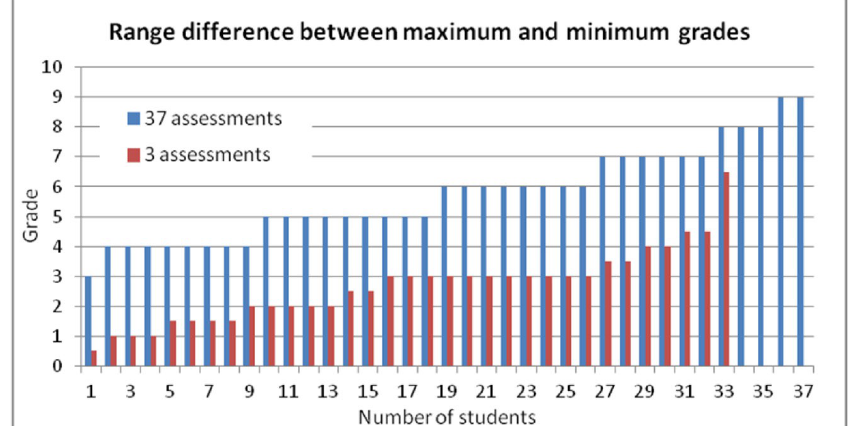
Figure 5. Comparison of peer assessments carried out for either 3 or 37 peers (whole-class